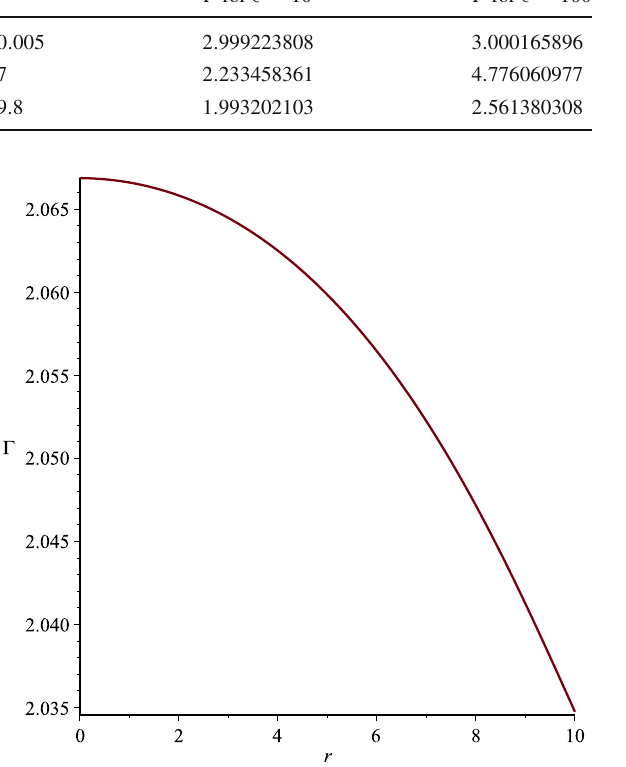
the behavior of (cid:26) with DM effects as given in Table 4 which appears consistent with the required